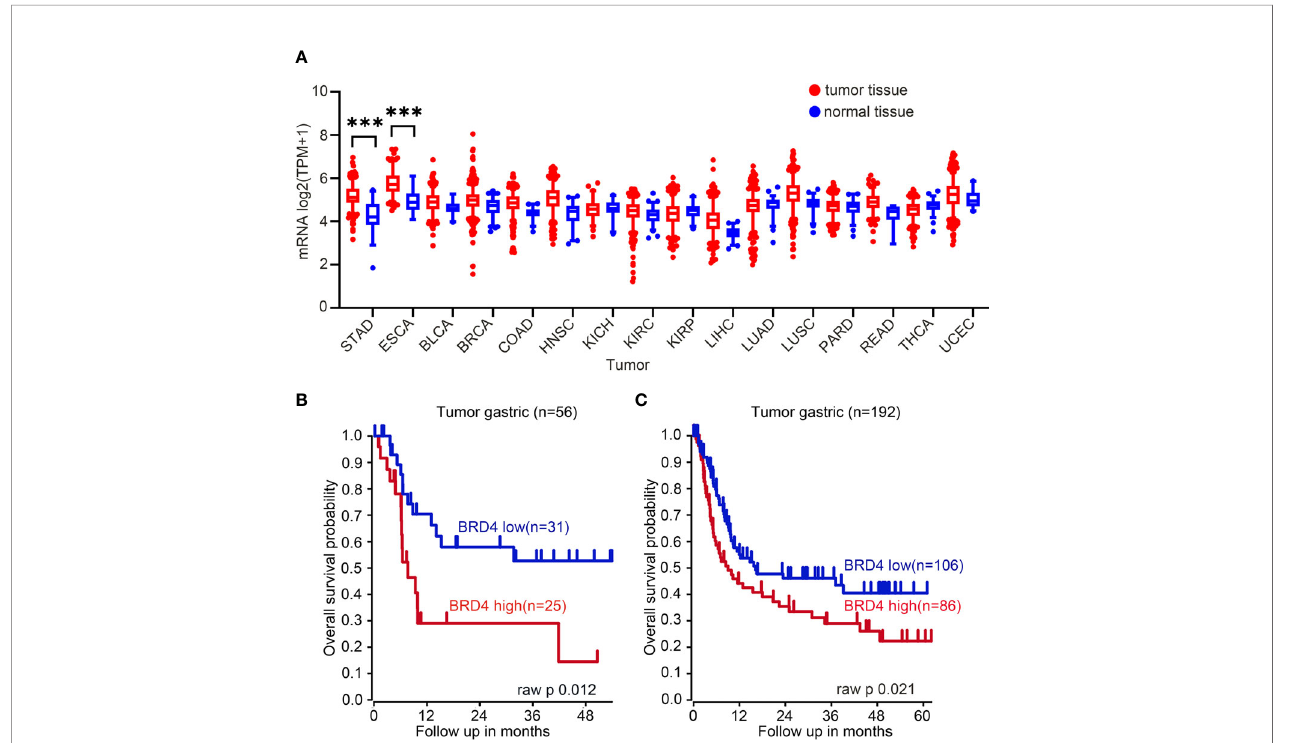
FIGURE 1 | BRD4 mRNA expression in tumor tissues and normal tissues. (A) BRD4 mRNA expression in tumor tissues and normal tissues (generated from the web site: http://gepia.cancer-pku.cn/index.html). The mRNA expression of BRD4 in gastric cancer raised signi fi cantly than that in normal tissues, there is a similar performance in esophageal adenocarcinoma tissues and normal tissues. STAD, stomach adenocarcinoma; ESCA, esophageal carcinoma; HNSC, head and neck squamous cell carcinoma; KICH, kidney chromophobe; BLCA, bladder urothelial carcinoma; KIRC, kidney renal clear cell carcinoma; UCEC, uterine corpus endometrial carcinoma; THCA, thyroid carcinoma; COAD, colon adenocarcinoma; LUSC, lung squamous cell carcinoma; KIRP, kidney renal papillary cell carcinoma; READ: rectum adenocarcinoma; BRCA: breast invasive carcinoma; PRAD, prostate adenocarcinoma; LUAD, lung adenocarcinoma; LIHC, liver hepatocellular carcinoma. (B) Overall survival curve including 56 patients with gastric cancer. Kaplan – Meier curves were generated from gastric tumor (Tan-56-fRMA-u133p2; source: GEO ID, gse34942). (C) Overall survival curve including 192 patients with gastric cancer (Tan-192-fRMA-u133p2; source: GEO ID, gse15459). Survival curve data originated from R2 Platform (http://r2.amc.nl). The cutoff point of high or low BRD4 expression was median survival time. *** p <